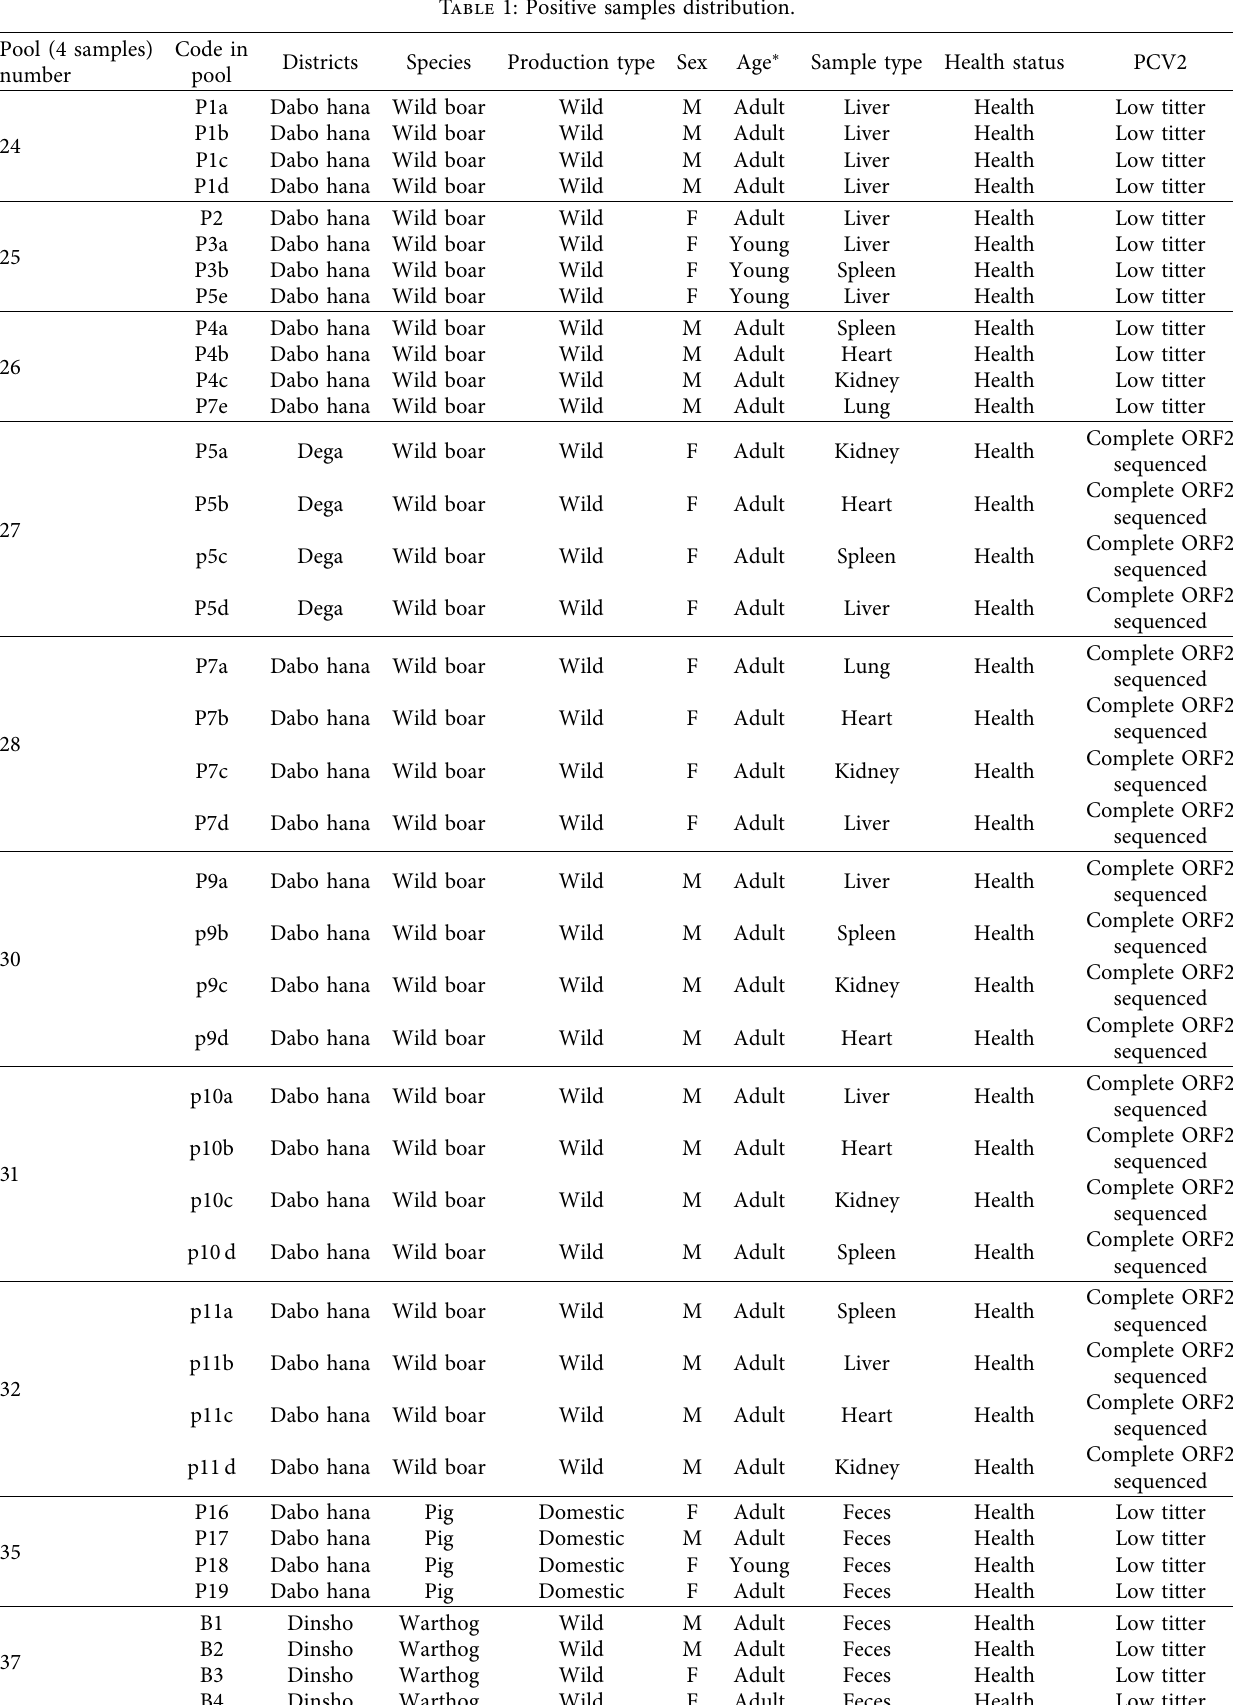
Table 1: Positive samples